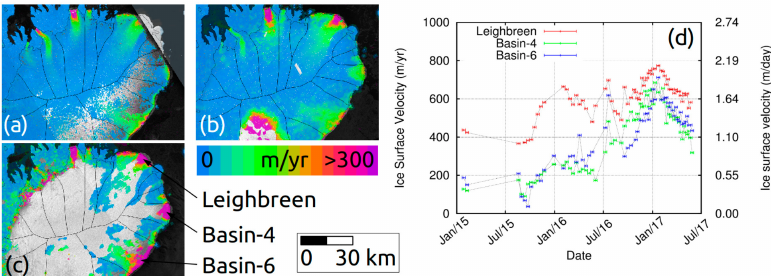
Figure 12. Ice surface velocity maps for the north-eastern tip of Austfonna (Svalbard) from ALOS-1 PALSAR-1 in 2008 ( a ), Sentinel-1 from 21/01/2015 to 02/02/2015 ( b ) and Sentinel-1 from 17/03/2017 to 29/03/2017 ( c ) and Sentinel-1 time-series of velocity for three glacier fronts from 2015 to 2017 ( d ). The arrows point to the locations used for the time